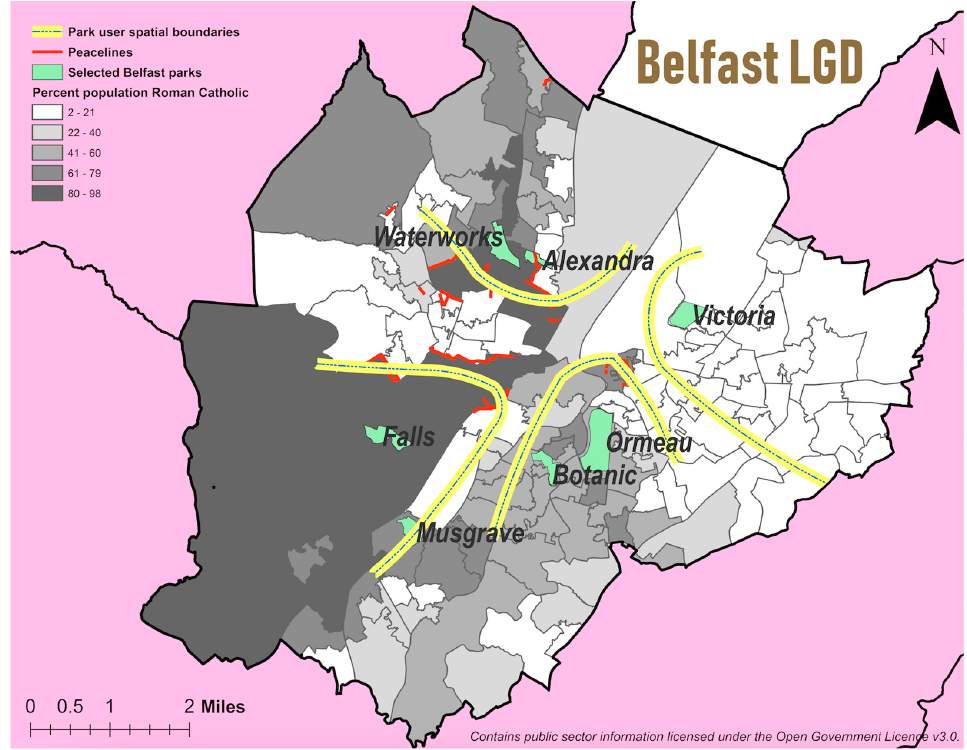
Figure 5. Spatial self-regulation in the use of parks in Belfast.